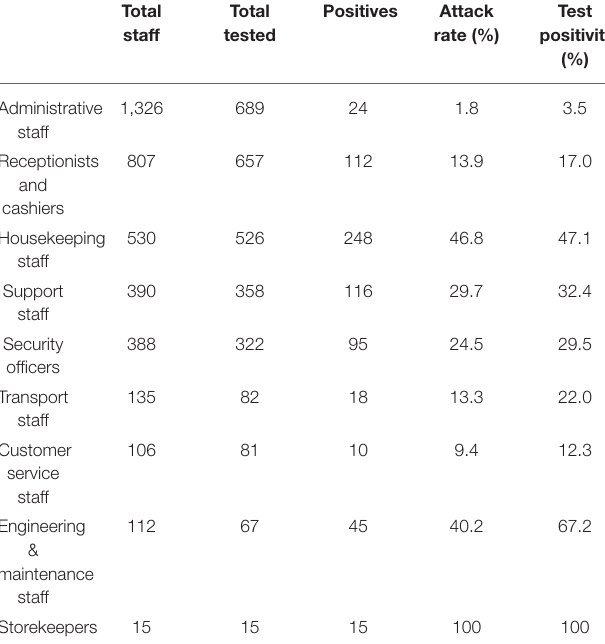
TABLE 3 | Attack rate and test positivity among non-clinical